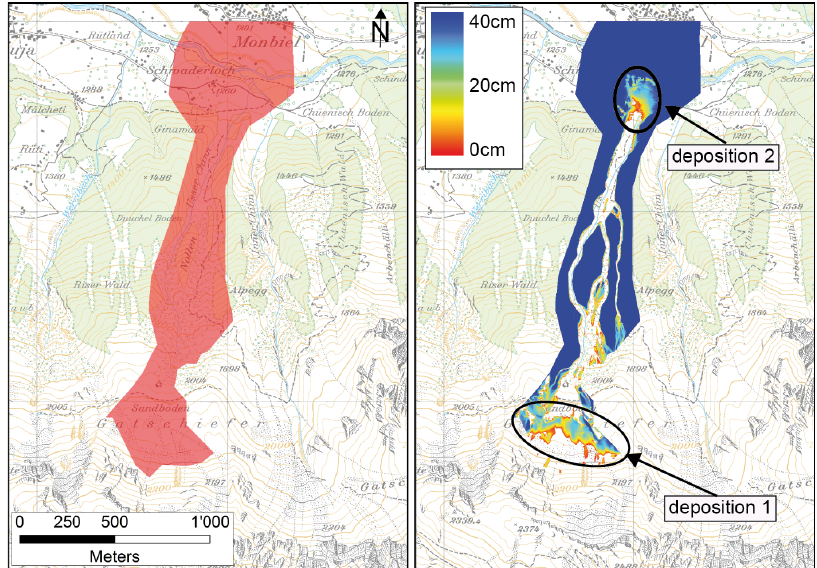
Fig. 12. On the left: erosion domain. The erodible snowpack was defined as a layer of height h es = 0 . 40m, density ρ es = 500kgm − 3 and k = 0 . 75. On the right: back-calculation of the Gatschiefer avalanche. The avalanche entrained most of the erodible snowpack with the exception of a little snow under deposition ] 1 and ]